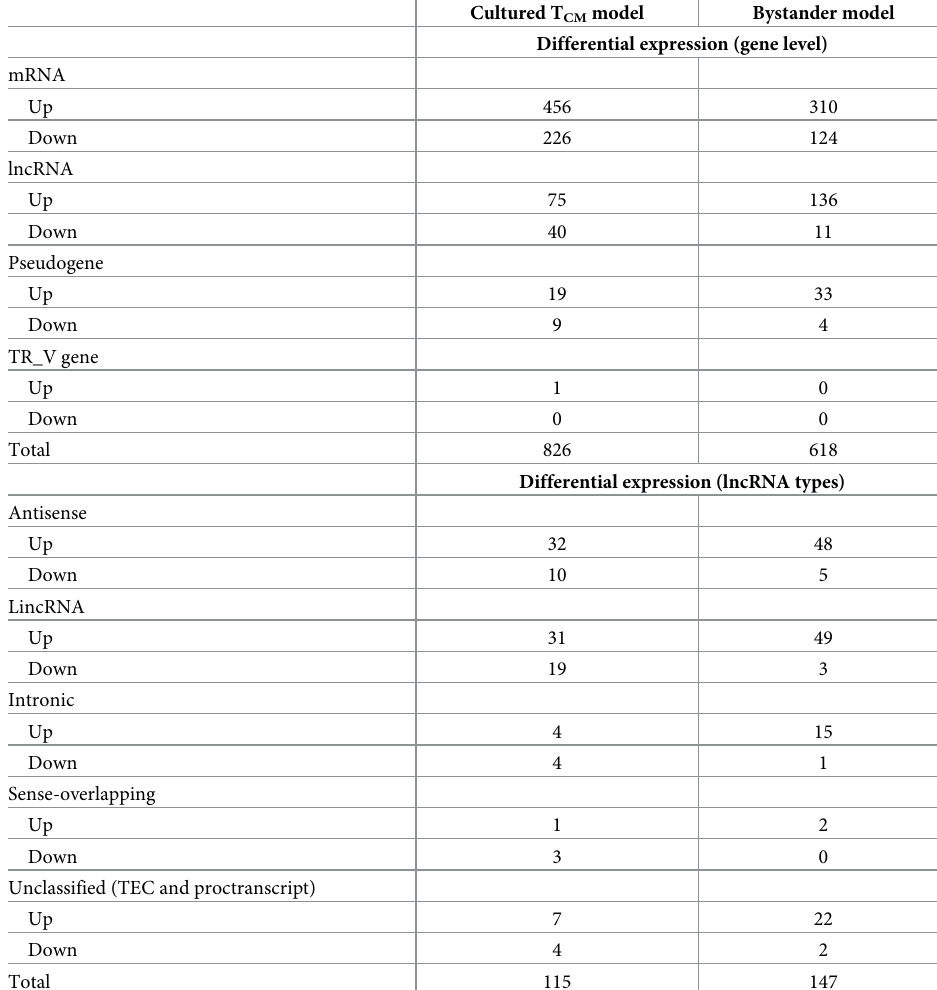
Table 1. Overview of differentially expressed protein coding genes and